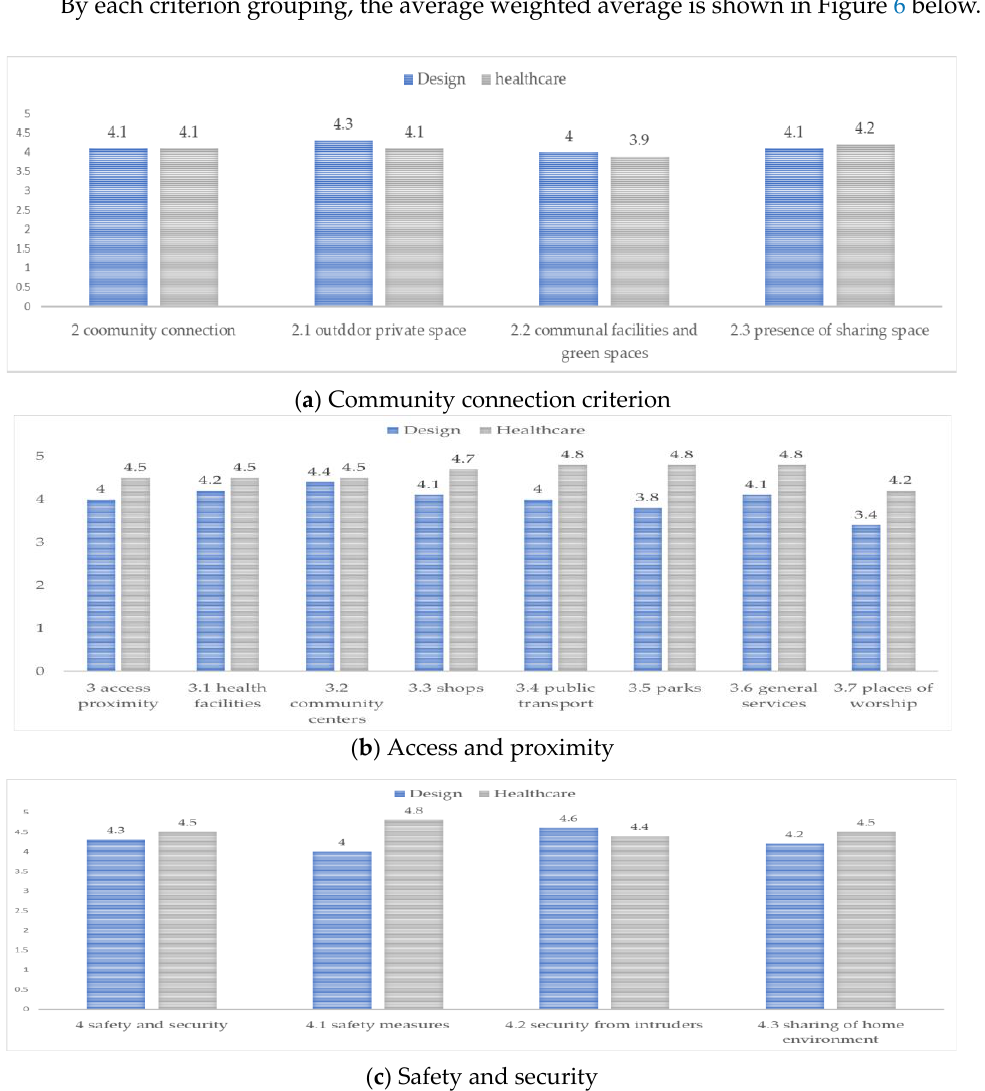
Figure 6. Aging-in-place dwelling criteria: ( a ) community connection; ( b ) access proximity, and ( c ) safety and security.